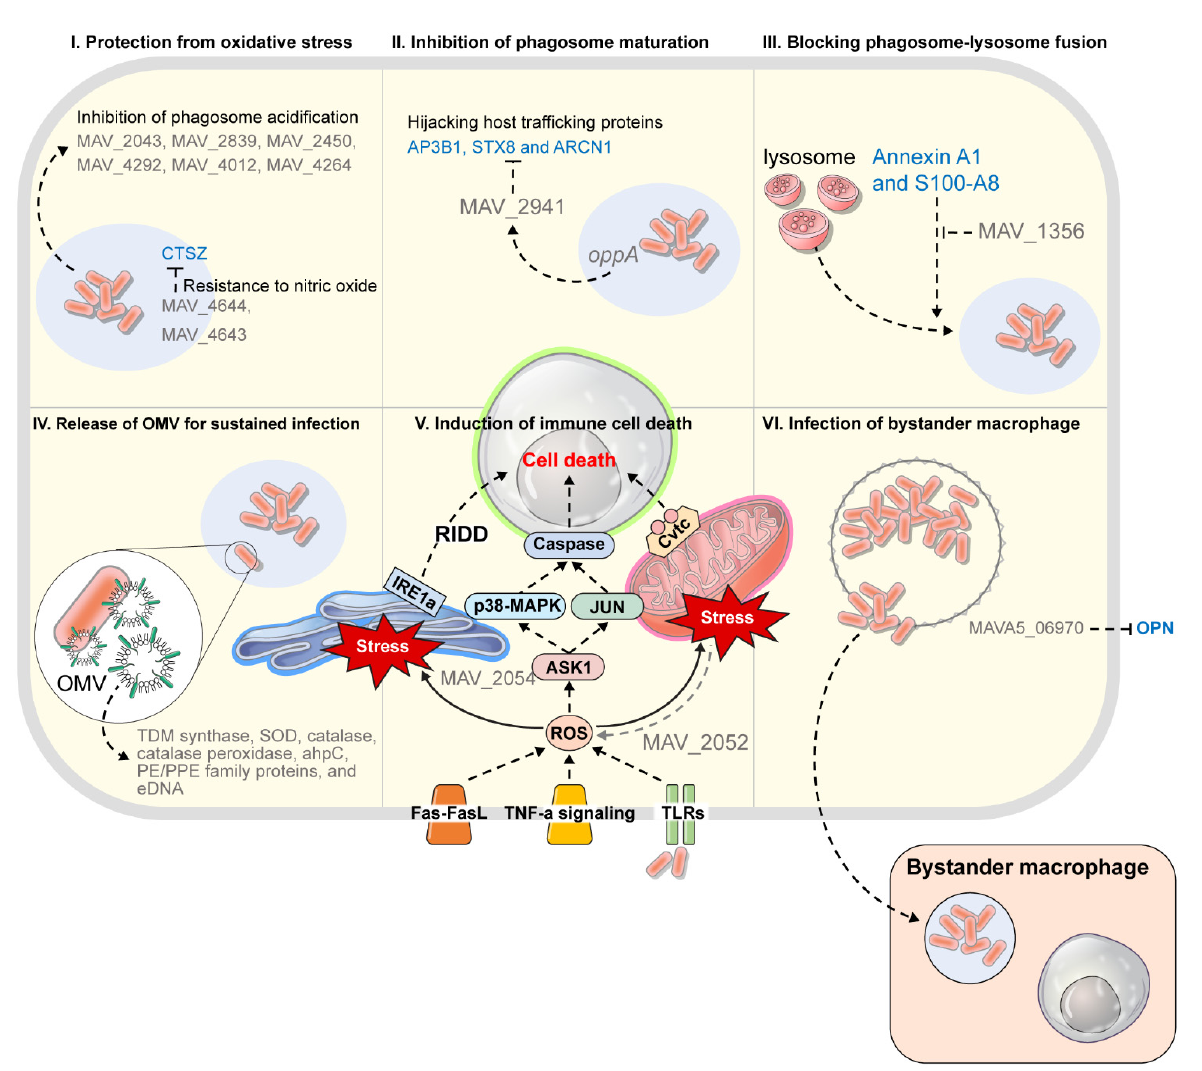
Figure 2. Summary of survival tactics of MAH within phagocytes from host innate immune effectors MAH infection. Six representative survival strategy of MAH for a series of processes after macrophage phagocytosis was presented. I . Protection from oxidative stress. In the early stages of macrophage infection, MAH expresses genes resistant to oxidative stress. II . Inhibition of phagosome maturation. MAH proteins expressed in the early stages of infection hijack host trafficking proteins, and interfere with their actions, eventually delaying the maturation of the endosome. III . Blocking phagosome-lysosome fusion. MAH proteins regulate phagosome membrane or block phagosome-lysosome fusion. IV . Release of OMV for sustained infection. MAH releases infection maintenance substances such as TDM synthase, SOD, catalase, catalase peroxidase, ahpC, PE / PPE family protein, and eDNA through OMV. V . Induction of immune cell death. MAH-infected